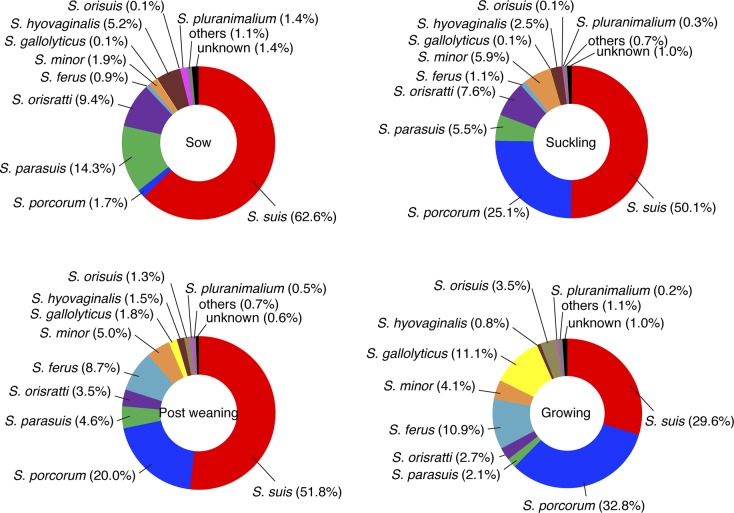
Comparison of species distribution in the genus Streptococcus between different growth stages of the pigs.Twenty different species were identified. The top 10 streptococcal species are depicted in different colors. The remaining 10 species are indicated as “others.” The other OTUs identified as Streptococcus were not matched to the sequences of the original database; these are indicated as “unknown”.